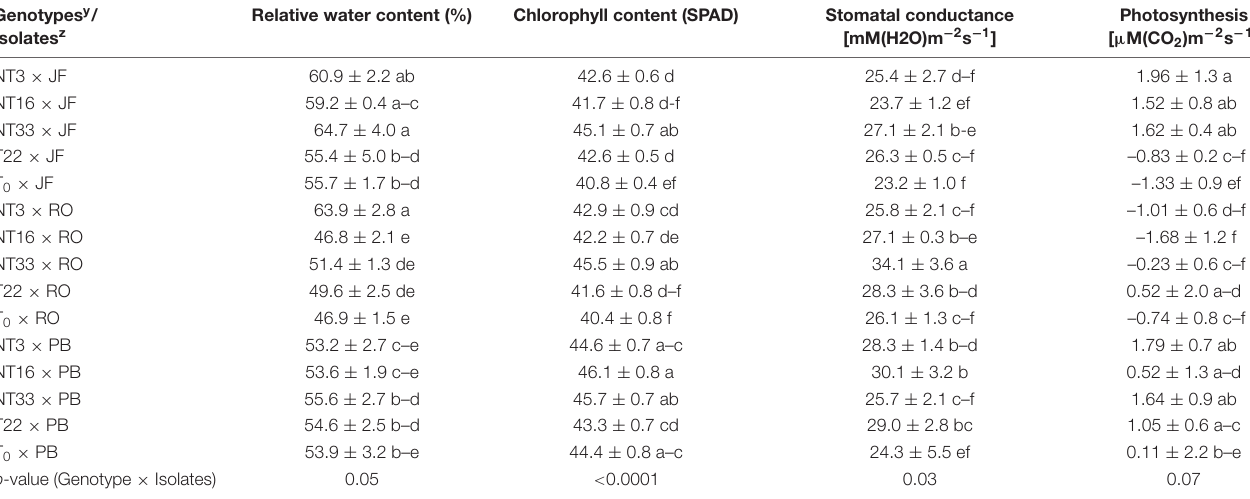
TABLE 3 | Effect of four Trichoderma isolates on chlorophyll content, relative water content, stomatal conductance and net photosynthesis on three tomato genotypes under water deficit stress conditions x . Genotypes y / Isolates z